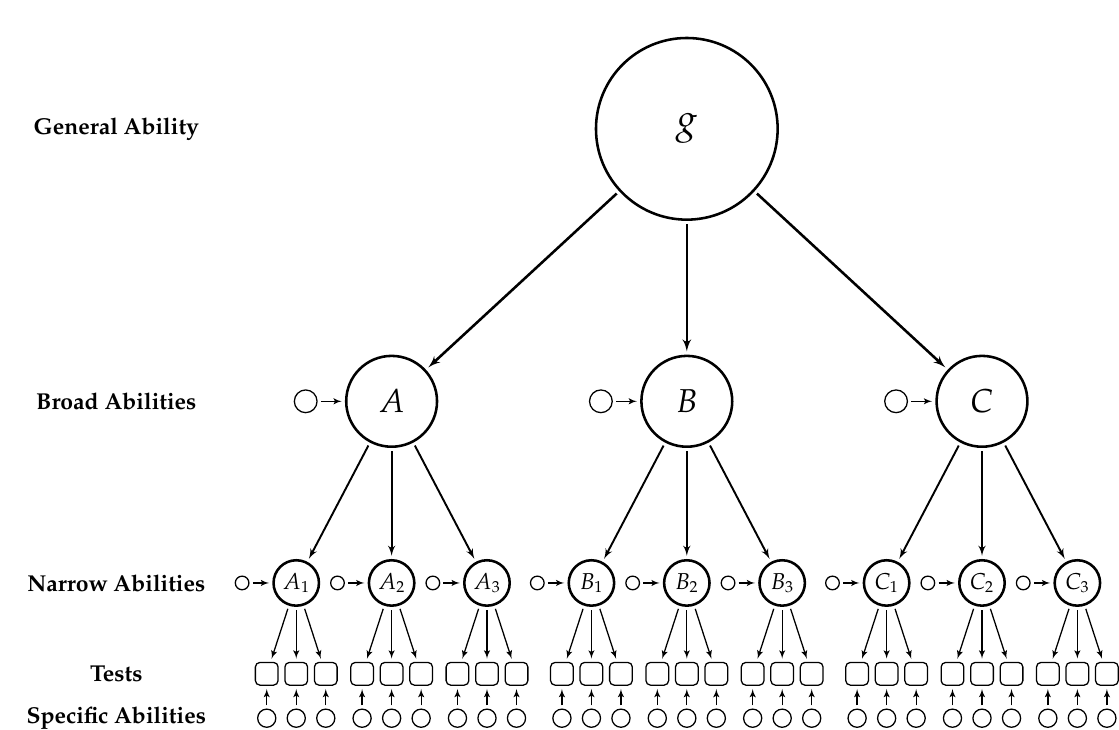
Figure 1. A tidy hierarchical